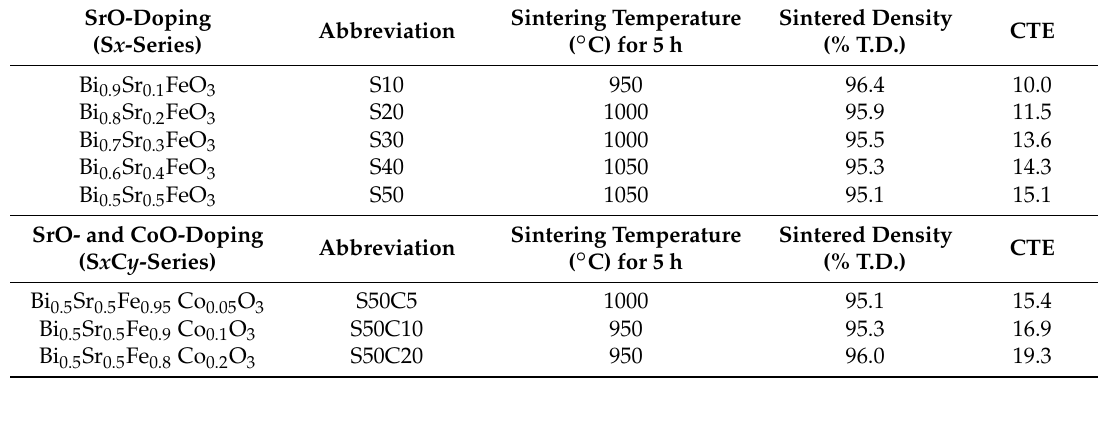
Table 1. Abbreviations and properties of Bi 1 − x Sr x FeO 3 ( x = 0.1 to 0.5) and Bi 0.5 Sr 0.5 Co y Fe 1 − y O 3 ( y = 0 to 0.2).